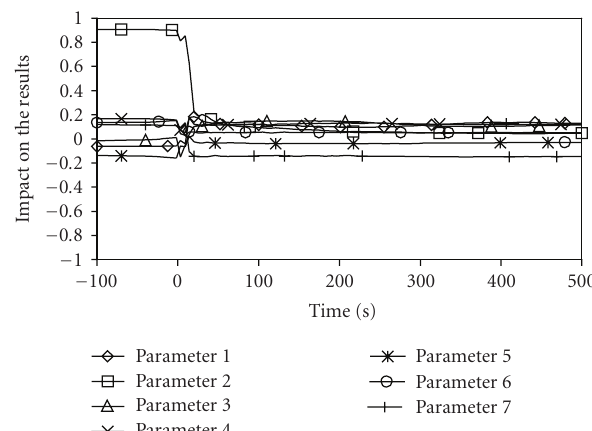
Figure 6: Loss-of-all-MCPs event. The impact of parameters no.1– 7 on the coolant flow rate through one MCC loop. The numbering of parameters is the same as in Table 1.